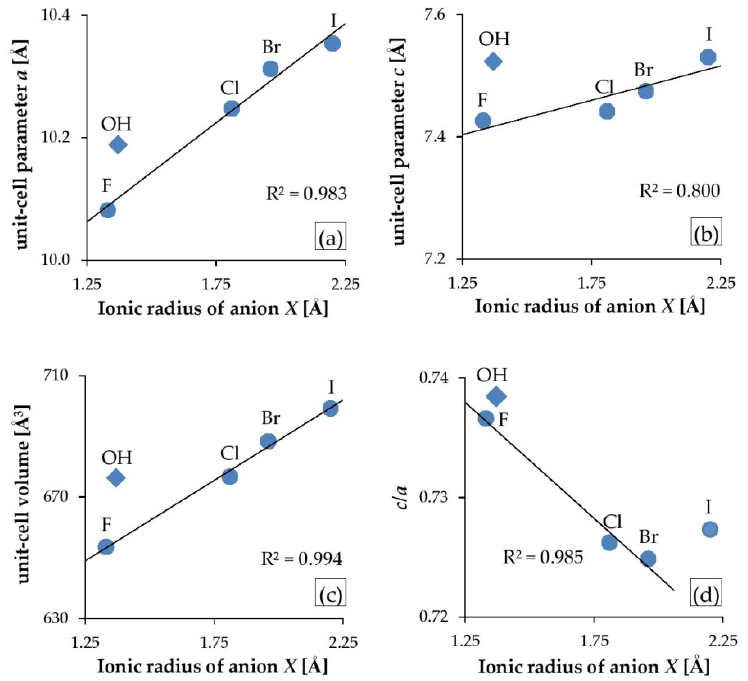
Figure 4. Variation in unit-cell parameters of substituted mimetites: ( a ) parameter a , ( b ) parameter c , ( c ) unit-cell volume, and ( d ) c / a ratio, compared with a substituting anion’s ionic radius, where ionic radius for F = 1.33 Å, OH = 1.37 Å, Cl = 1.81 Å, Br = 1.96 Å, and I = 2.20 Å. Mimetite-OH (diamonds) does not adhere to the trends.